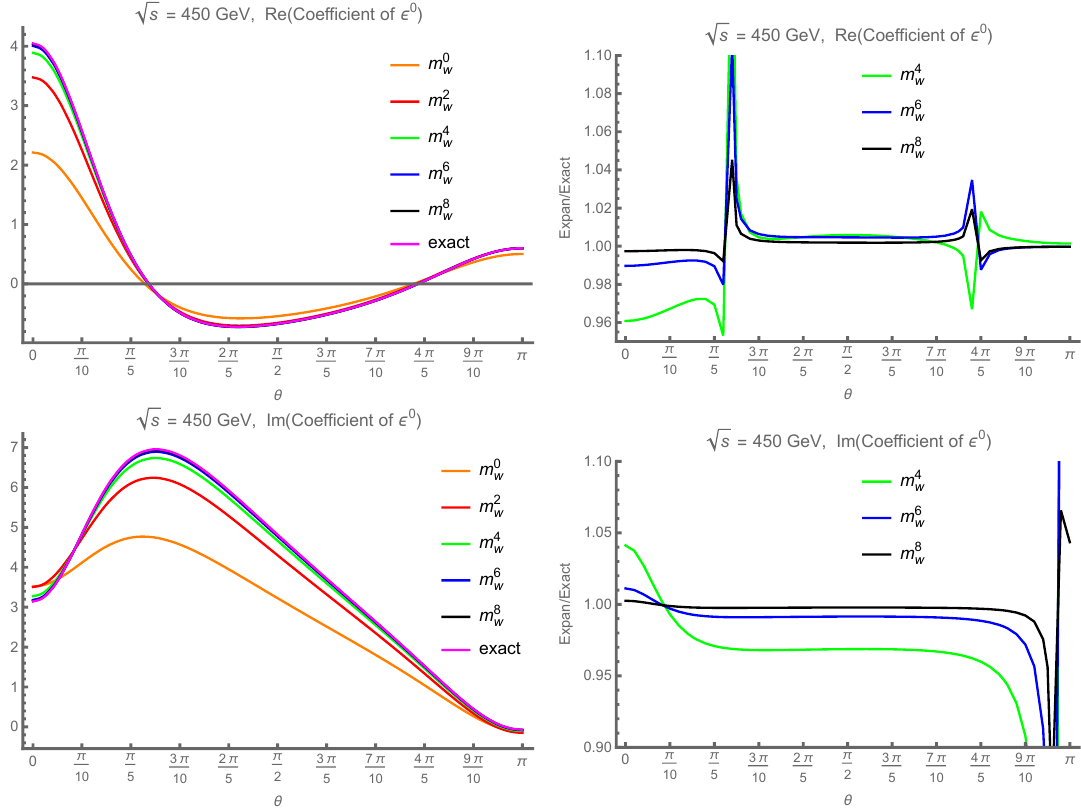
Figure 4. The real (upper plots) and imaginary (lower plots) parts of the (cid:15) 0 coefficient of (1 /m 6 ) I NP2 ( m 2 ) as a function of θ with t 1 , 1 , 1 , 1 , 1 , 1 , 1 , 0 , 0 W